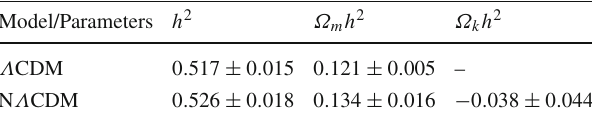
Table 3 The mean and uncertainty of parameters in Λ CDM and N Λ CDM using MCMC method